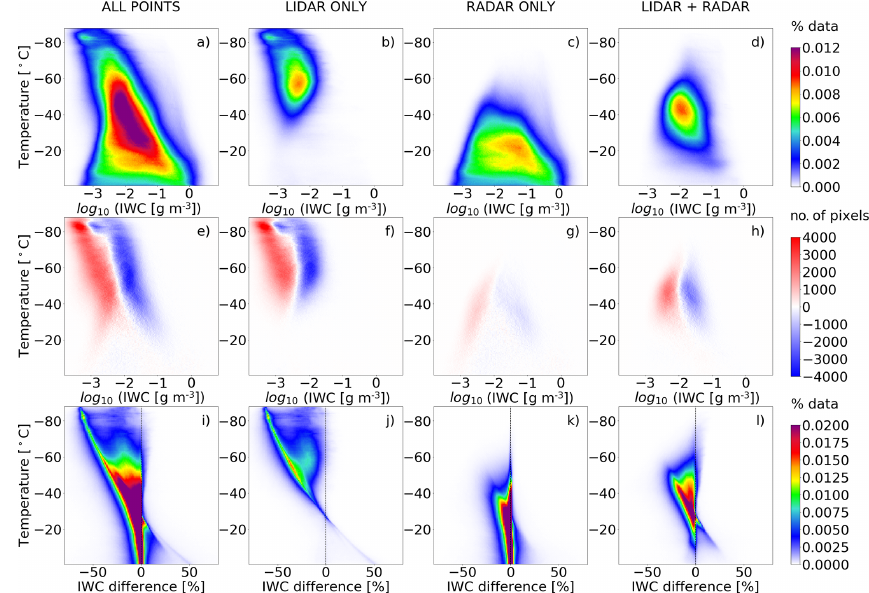
Figure 8. Comparison of the retrieved IWC for the V 2 and V 3 a priori parameterizations of the lidar ratio: probability density distributions of log 10 ( IWC ) as a function of temperature obtained when using the new configuration ( V 3 ) (a–d) , differences in the log 10 ( IWC ) distributions in terms of number of retrieved pixels for each [log 10 ( IWC ) − T ] bin (e–h) , and finally the distribution of the relative difference between IWC obtained with the new V 3 lidar ratio a priori and IWC obtained with the old V 2 configuration, IWC 3 The first column shows the distributions for all retrieved pixels, the second column, for lidar-only pixels, the third column, for radar-only pixels, and the last column for lidar–radar